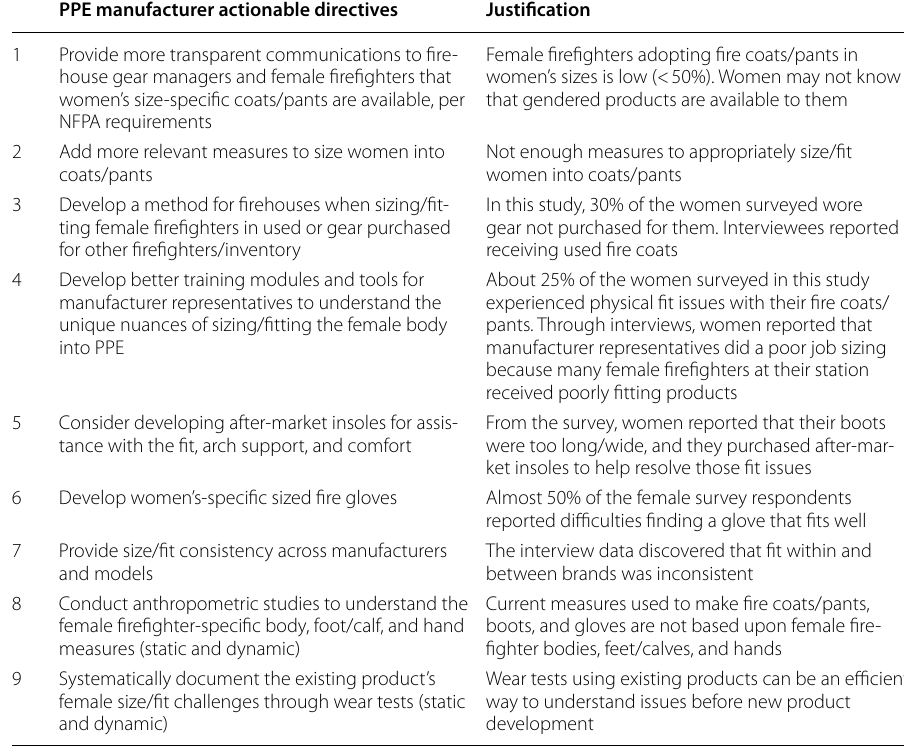
Table 10 Actionable directives that manufacturers could integrate, per survey results and 1:1